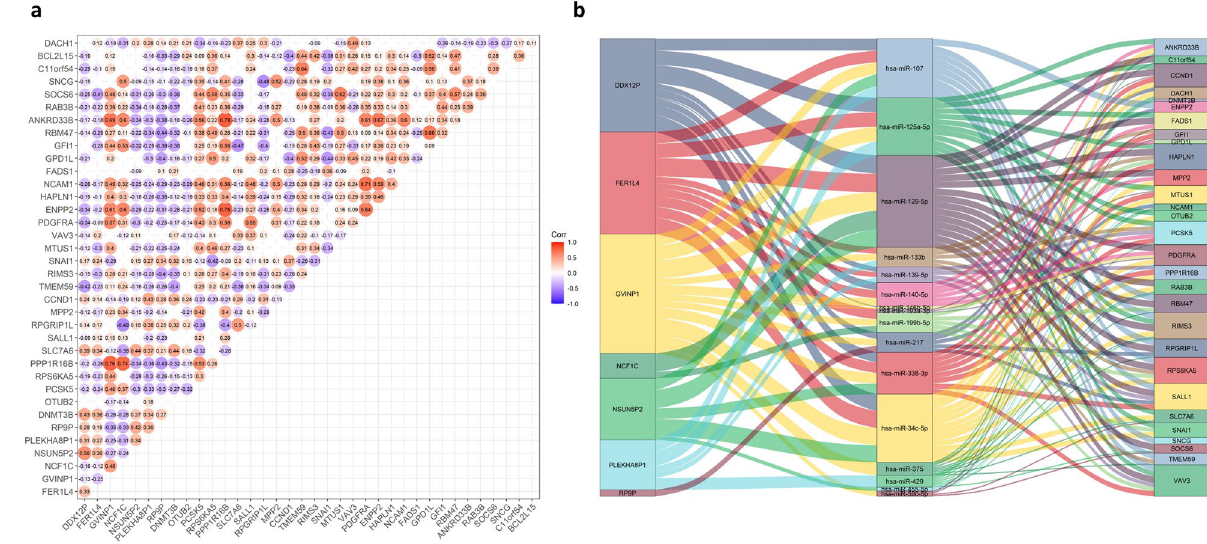
Figure 4. Survival-related 7 DE pseudogenes and ceRNA network. ( a ) Pearson correlation analysis of the 7 survival-related pseudogenes and 29 survival-related mRNAs with p < 0.05. Red presents a positive correlation and purple presents a negative correlation. ( b ) Sankey diagram showing interactions between the 7 pseudogenes and their matched miRNAs and mRNAs that were significantly related to survival. Each rectangle represents a gene, and the connection degree of each gene is visualized based on the size of the